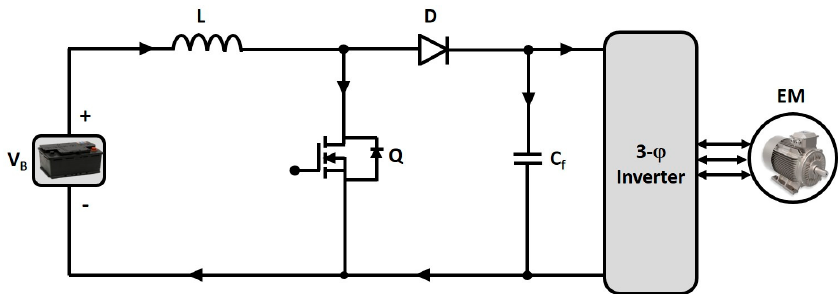
Figure 22. Conventional Boost DC–DC Converter.